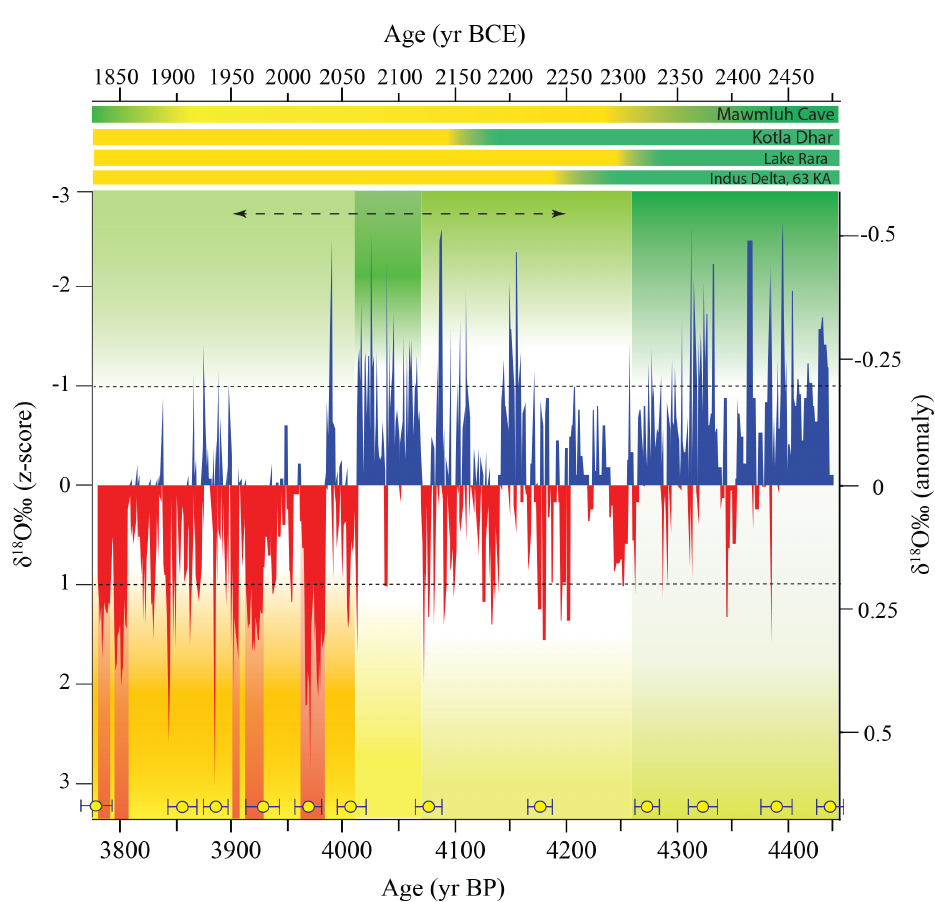
Figure 8. The inferred pattern of ISM variability during the 4.2ka event: the ML.1 δ 18 O record is shown here as z score (left y axis) and anomalies (right y axis). The horizontal dashed lines indicate 1 standard deviation and the vertical color-saturated shaded bars denote periods of inferred drier (yellow) pluvial (green) and variable conditions. The vertical red bars delineate the periods of multi-decadal droughts ( z score > 1). The horizonal dashed double arrows mark the commonly accepted duration of the 4.2ka event (see text) and the horizontal shaded bars indicate broad hydroclimate patterns inferred from other regional proxy records as mentioned in the text (see also Figs. 1 and 2). The circles with 2 σ error bars show a subset of 230 Th dates (see Tables 1 and S1 for a complete listing of 230 Th